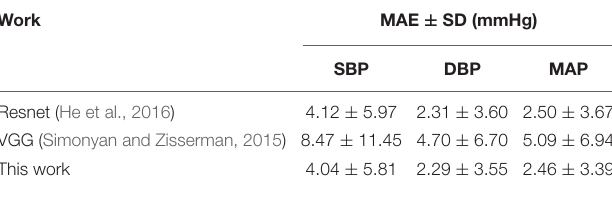
TABLE 7 | Impacts of that number of network channels and the size of channel convolution kernel on the performance of BP